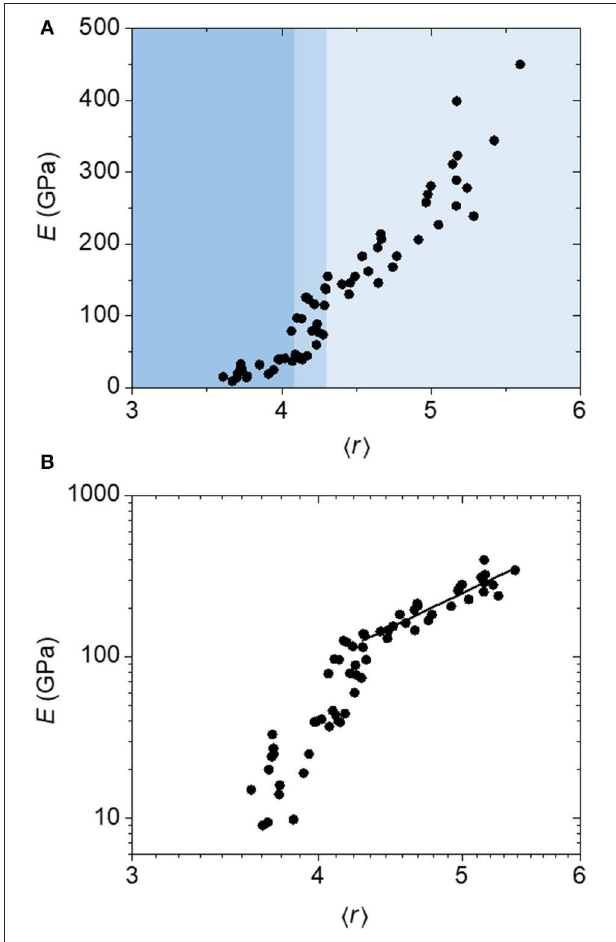
FIGURE 3 | (A) Linear and (B) log plots of Young’s modulus ( E ) as a function of average coordination number ( h r i ) calculated using an atomic constraint counting method for a-BC:H films. The data above the transition region is fit to a power-law function to yield an exponent of